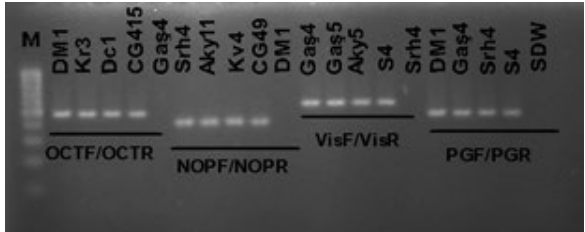
Figure 3. Representative 1% agarose gel of different opine types (M: Thermo scientific 100bp DNA ladder, DM1, Kr3, Dc1 are O/C-type strains, CG415: O/C-type reference strain; Srh4, Aky11, Kv4 are nopaline-type strains, CG49: Nopaline- type reference strain; Gaş4, Gaş5, Aky5 are vito - pine-type strain, S4: Vitopine- type reference strain, SDW: sterile distille